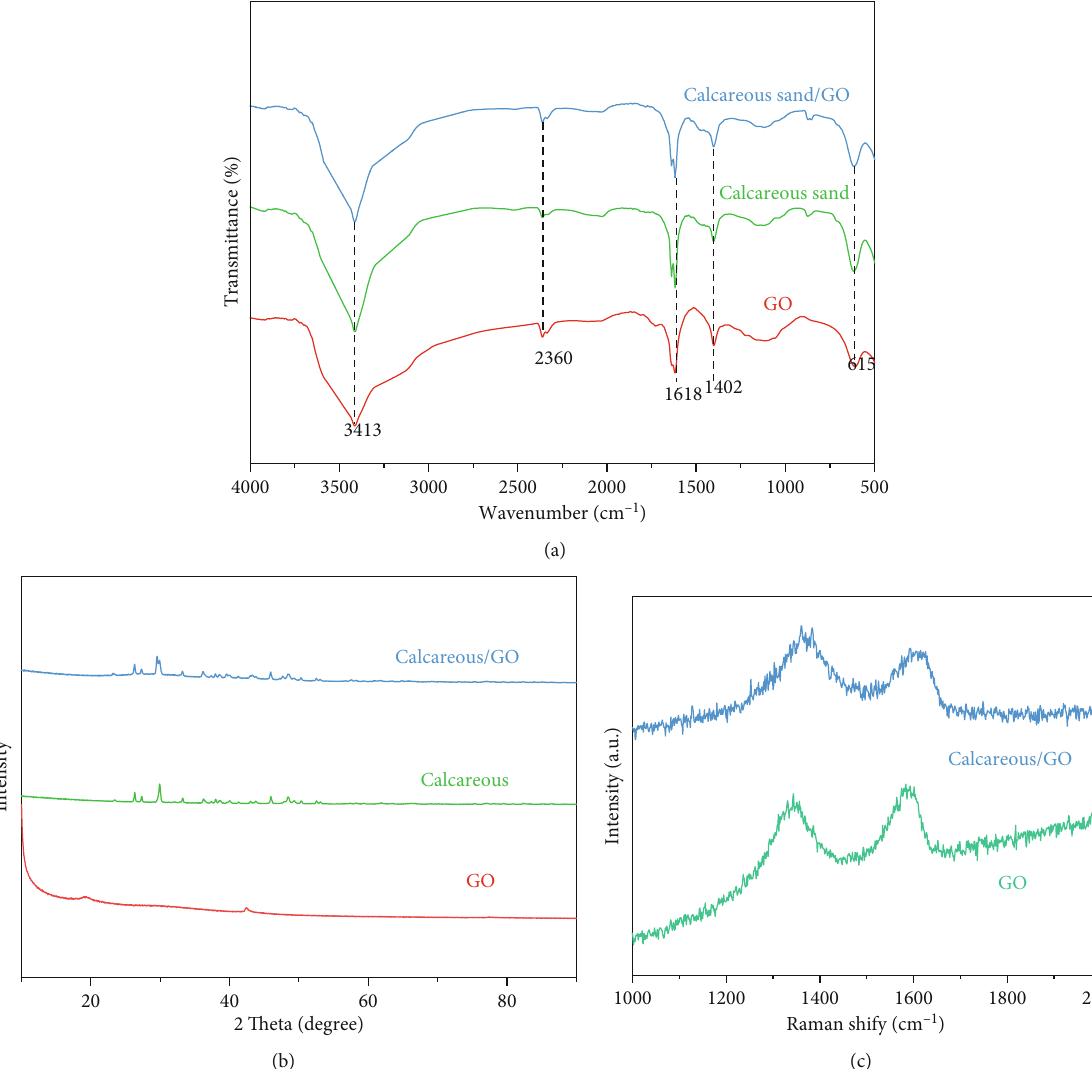
Figure 5: FT-IR spectra of GO, calcareous sand, and calcareous sand/GO (a); XRD patterns of GO, calcareous sand, and calcareous sand/ GO (b); and Raman spectra of GO and calcareous sand/GO